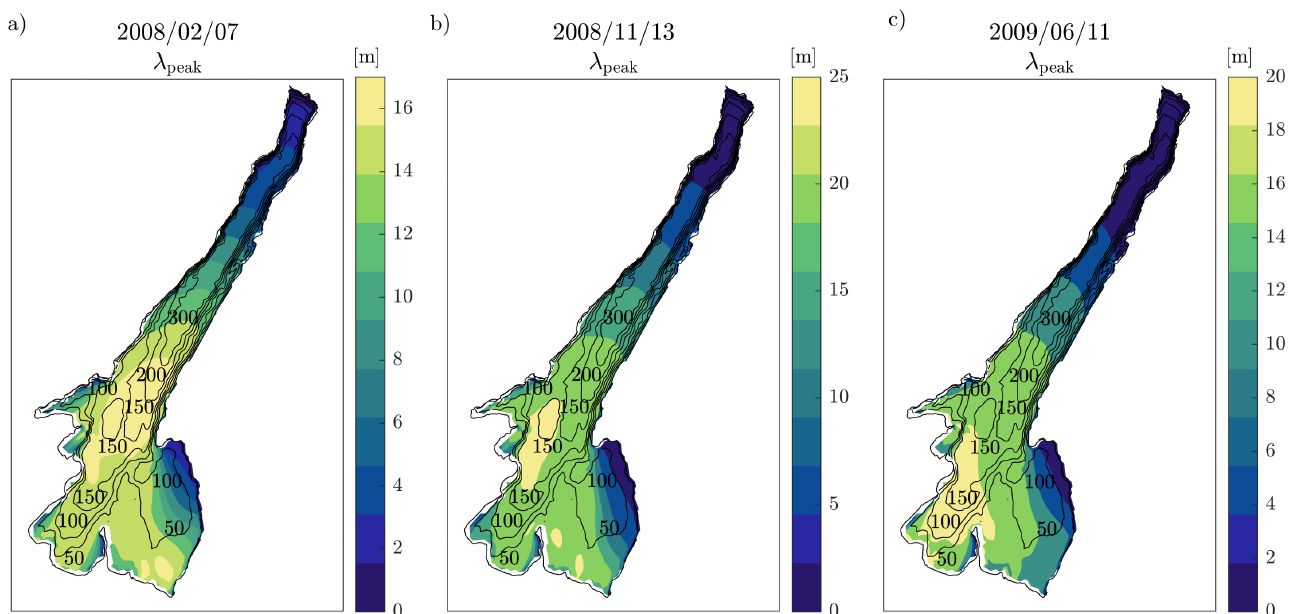
Figure 8. Maps of peak wavelength for high wind dates 7 February 2008 ( a ), 13 November 2008 ( b ), 11 June 2009 ( c